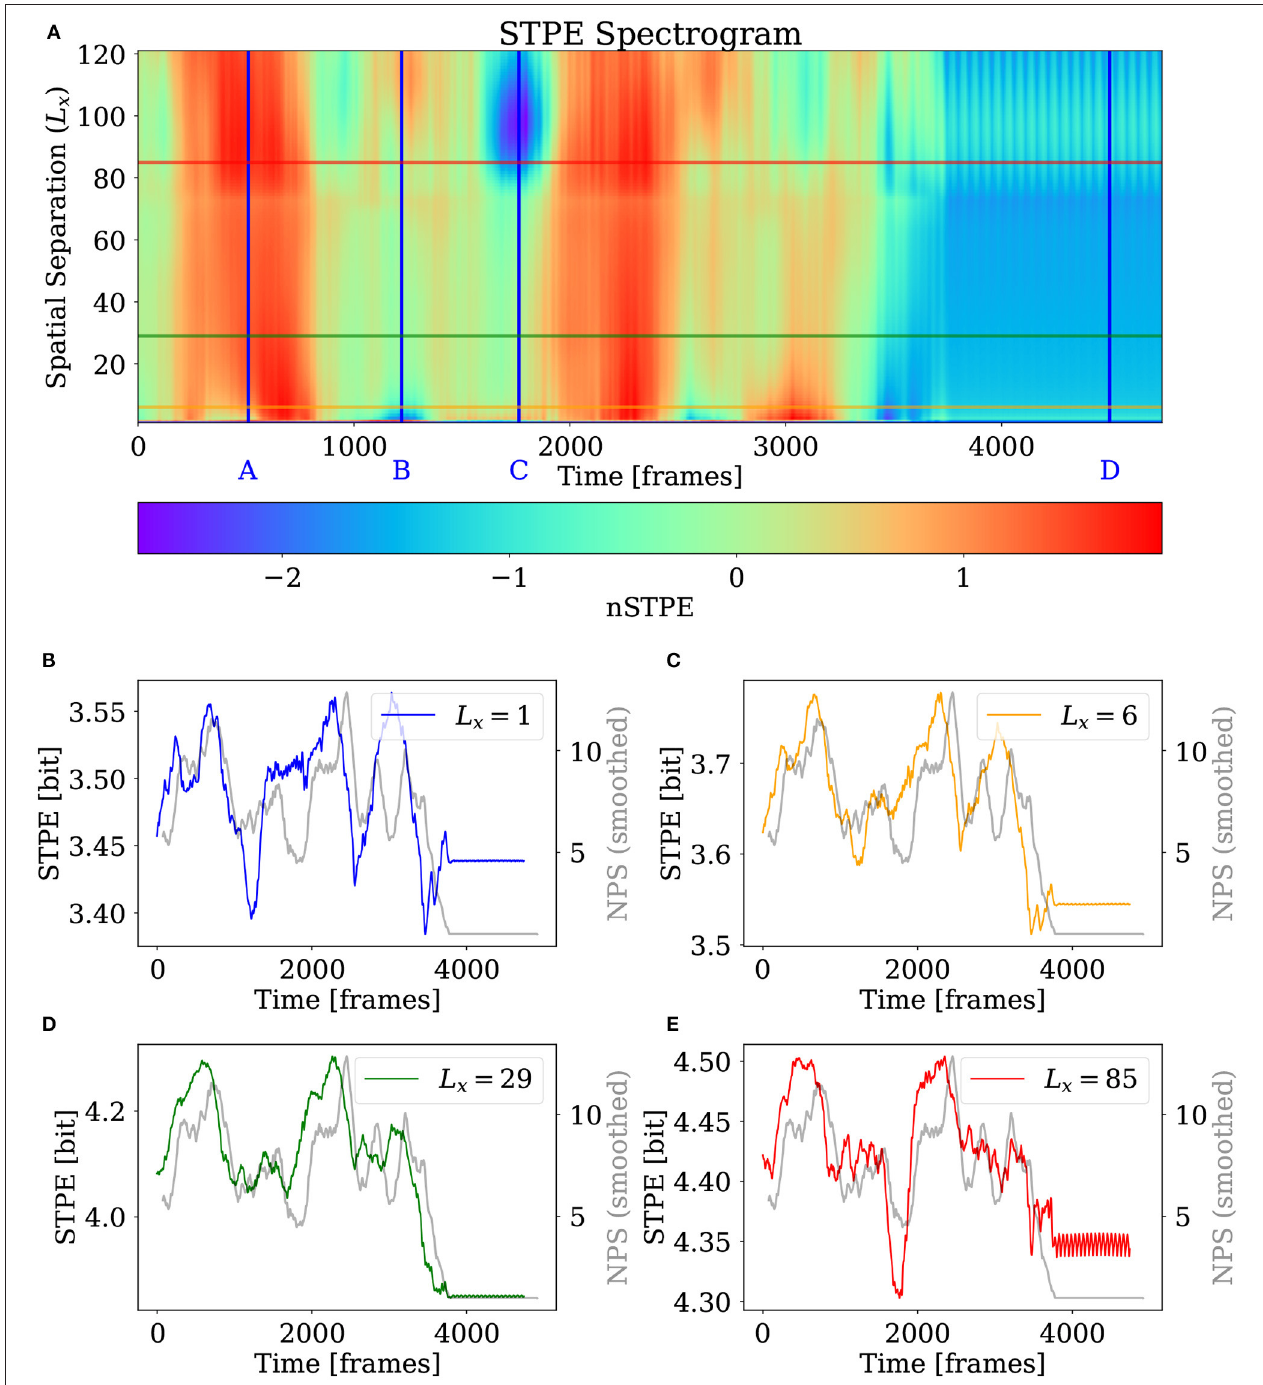
FIGURE 10 | STPE spectrogram and excerpts for the 2D simulation. (A) nSTPE displayed for different values of the spatial separation in a spectrogram-like view. The blue lines annotated with blue letters mark the frames which are shown in Figures 9A–D . (B–E) Show the time series for STPE at different values of the spatial separation together with NPS (gray). NPS has been smoothed using a moving average filter with a width of 155